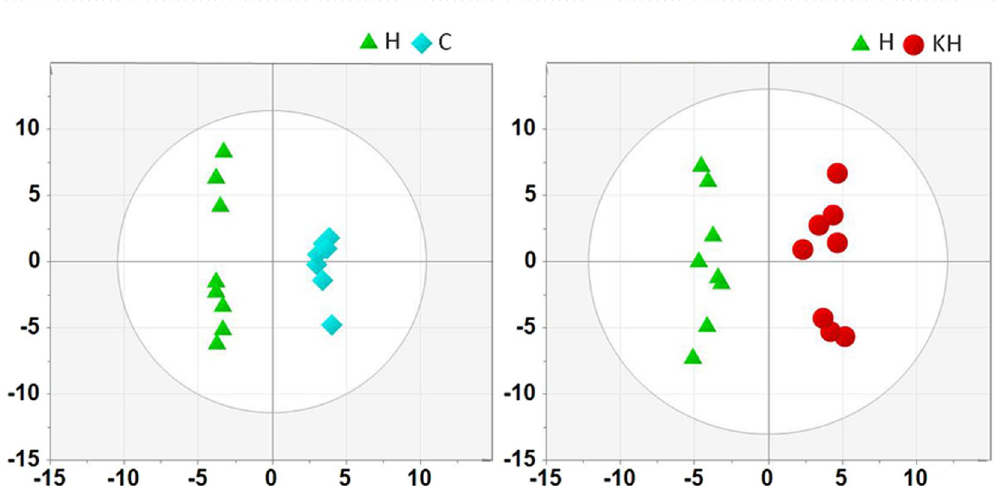
Figure 6. PLS-DA score plots generated from the PLS-DA of the GC/TOFMS data derived from the liver samples of rats. The blue square is the C group, the red dot is the H group and the green triangle is the KH group. C: control group; H: Heat stress group; KH group: Kisspeptin + Heat stress group. ( A ) R2X = 0.644, R2Y = 0.969; Q2 = 0.8; ( B ) R2X = 0.505,R2Y = 0.986,Q2 =